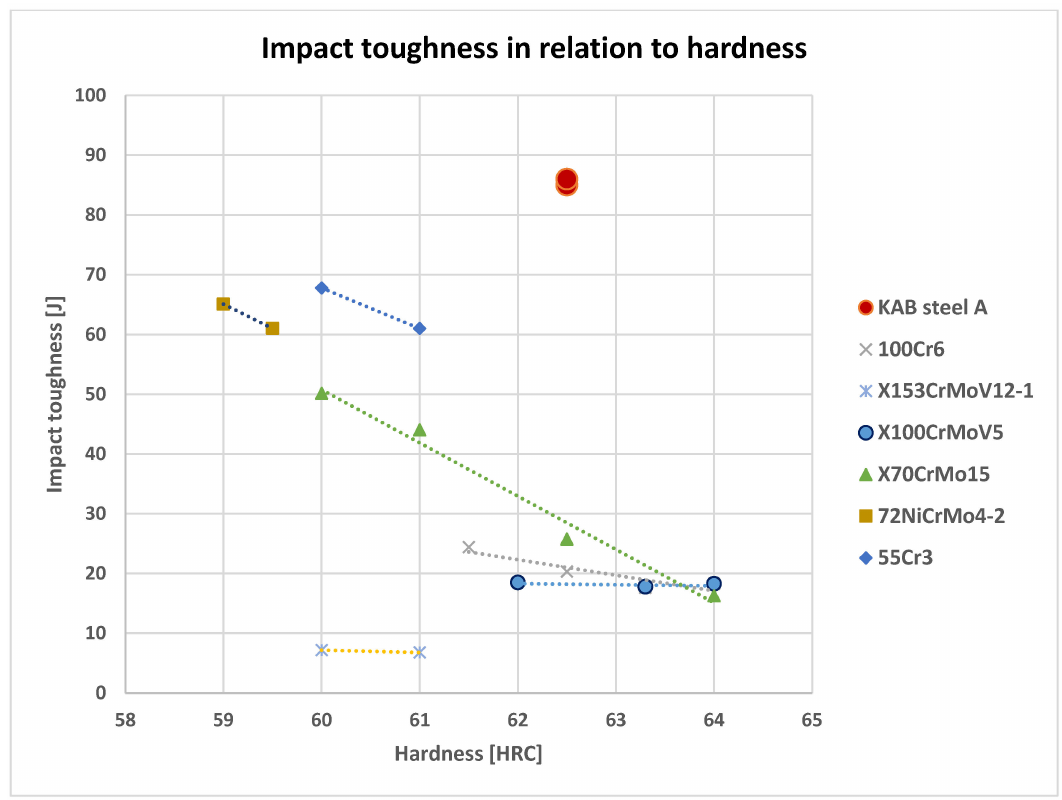
Figure 5. Toughness of experimental KAB steel compared to tool and low-alloy steels at similar hardness. Crack mouth opening displacement (CMOD)-crack growth/force curves were gener- ated for SENB specimens subjected to bending, as shown in Figure